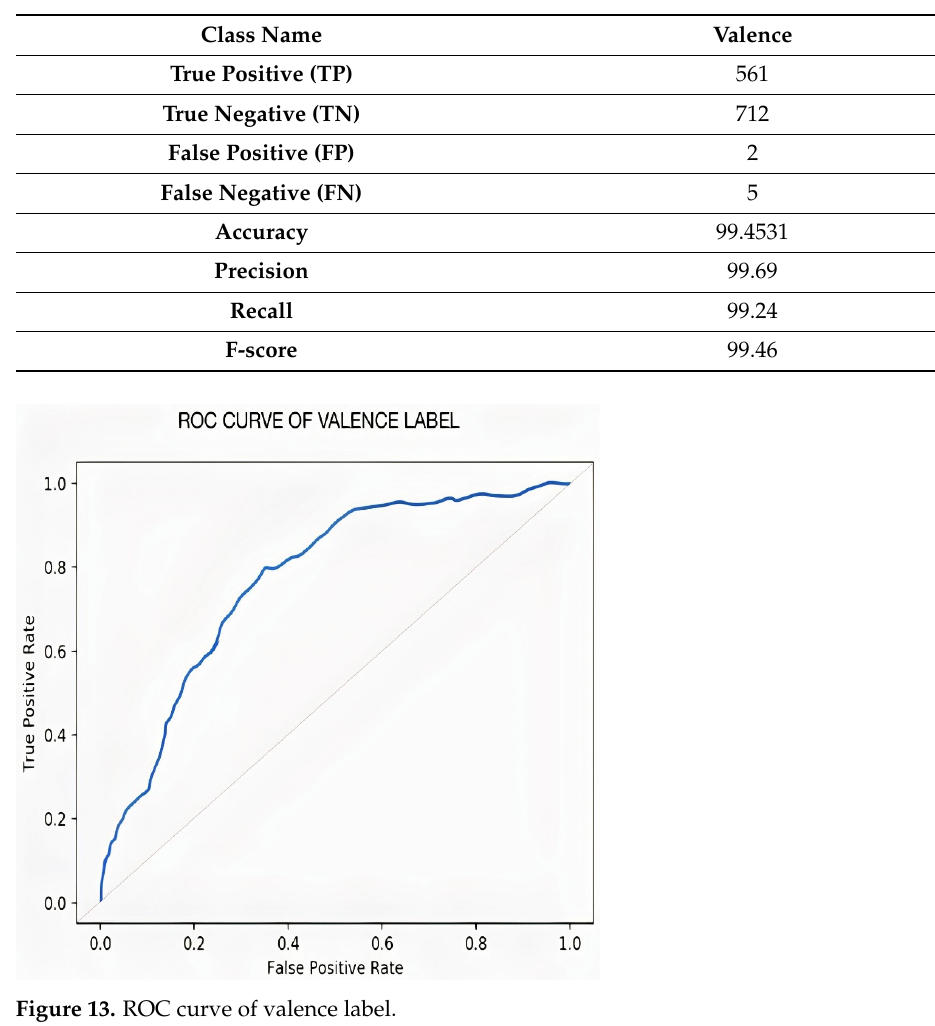
Figure 12. Confusion chart for valence label. Table 4. Valence label results.